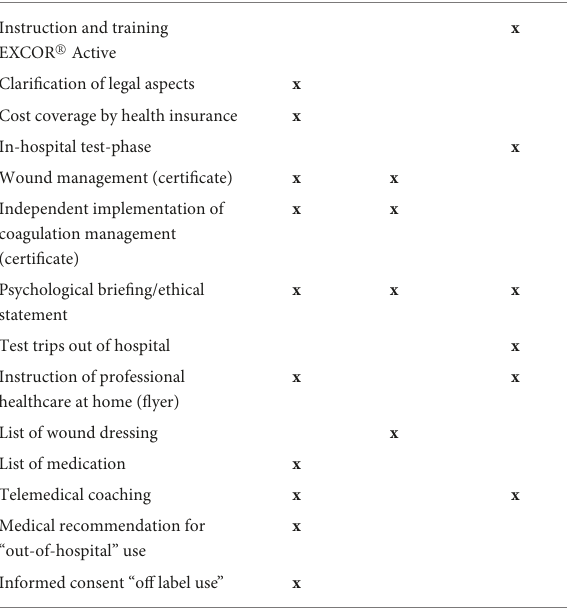
TABLE 3 Hands-on plan for establishing a home healthcare environment. Doctor Nursing